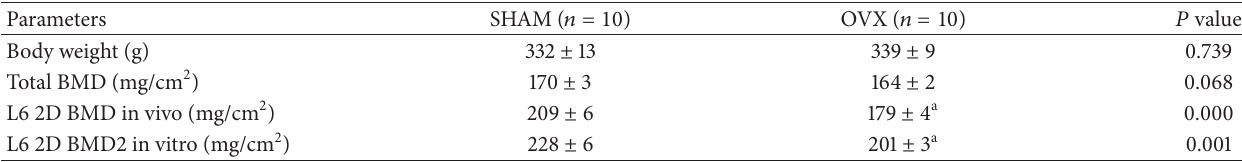
Table 1: Body weight and DXA measurements.